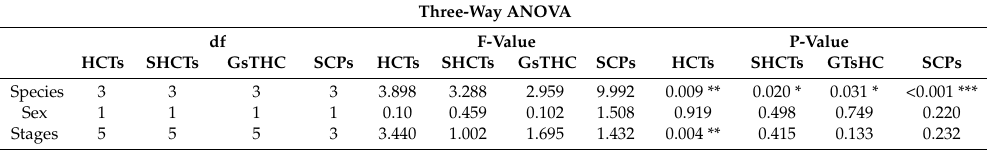
Table 2. Three-way ANOVA (species sex and stage) on the relationship between one of species, sex, and stage and semi heat coma temperatures (SHCTs), heat coma temperatures (HCTs), gap temperatures for heat coma (GTsHC) and super cooling points (SCPs) in the four species of oceanic sea skaters, Halobates micans ( H.m .), H. germanus ( H.g. ), H. sericeus ( H.s. ), and H. sp. in a dataset of several hundred to a thousand specimens. Three-Way ANOVA df F-Value P-Value HCTs SHCTs GsTHC SCPs HCTs SHCTs GsTHC SCPs HCTs SHCTs GTsHC SCPs Species 3 3 3 3 3.898 3.288 2.959 9.992 0.009 ** 0.020 * 0.031 * <0.001 *** Sex 1 1 1 1 0.10 0.459 0.102 1.508 0.919 0.498 0.749 0.220 Stages 5 5 5 3 3.440 1.002 1.695 1.432 0.004 ** 0.415 0.133